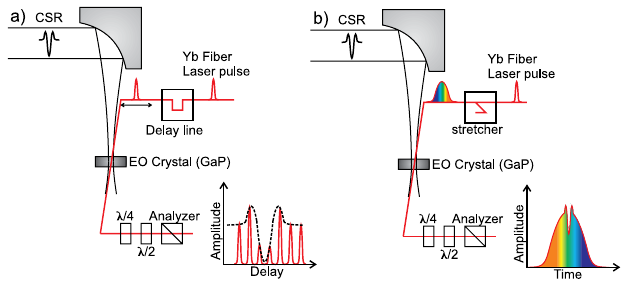
FIG. 7. Schematic of (a) the electro-optic sampling (EOS) and (b) the spectrally resolved electro-optic detection (EOSD) setup.